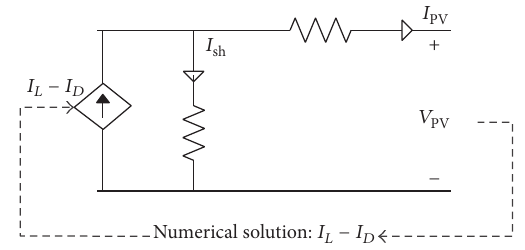
Figure 2: The numerical one-diode model for a PV